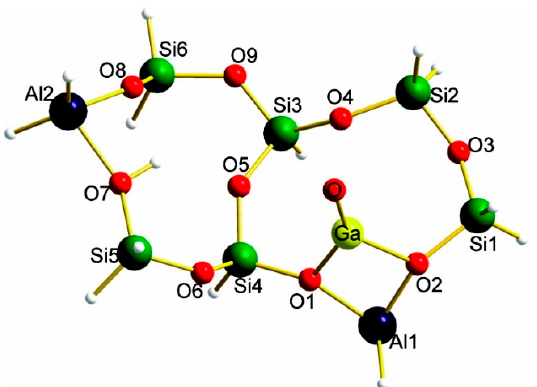
Figure 8. Optimized structure of the [GaO] + ion stabilized in the cluster model representing ZSM-5 zeolite. Reprinted with permission from ref [116]. Copyright 2007 American Chemical Society.